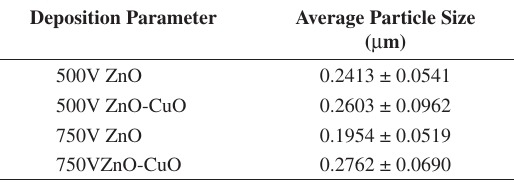
Table 1. Average particle sizes at different deposition parameters.